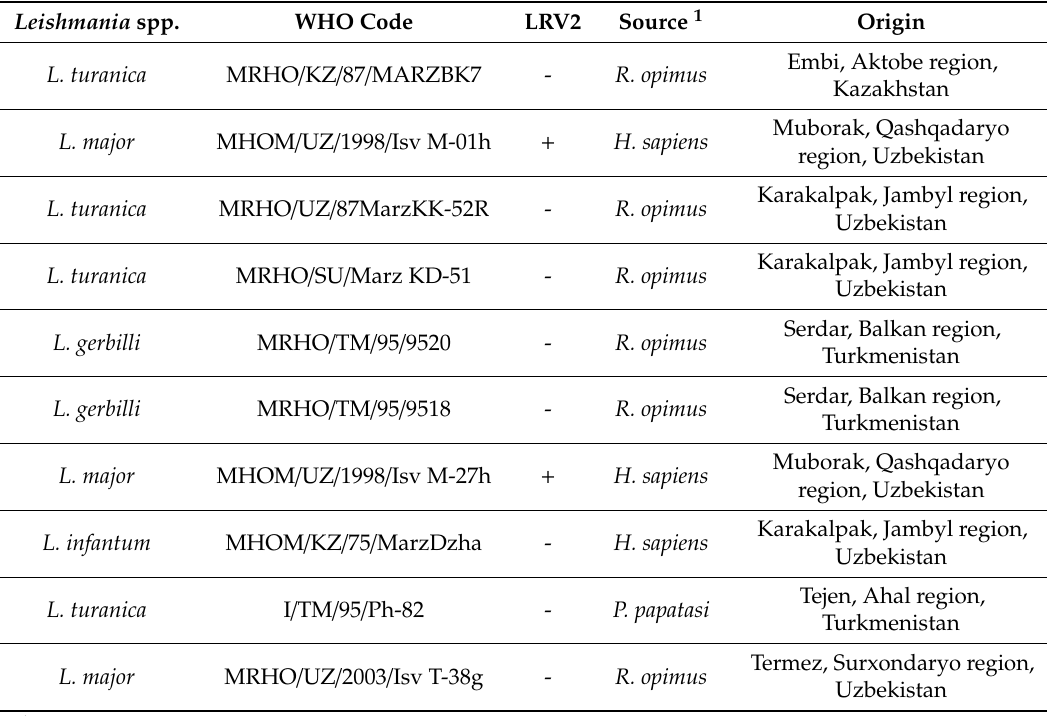
Table 1. Leishmania spp. analyzed in this